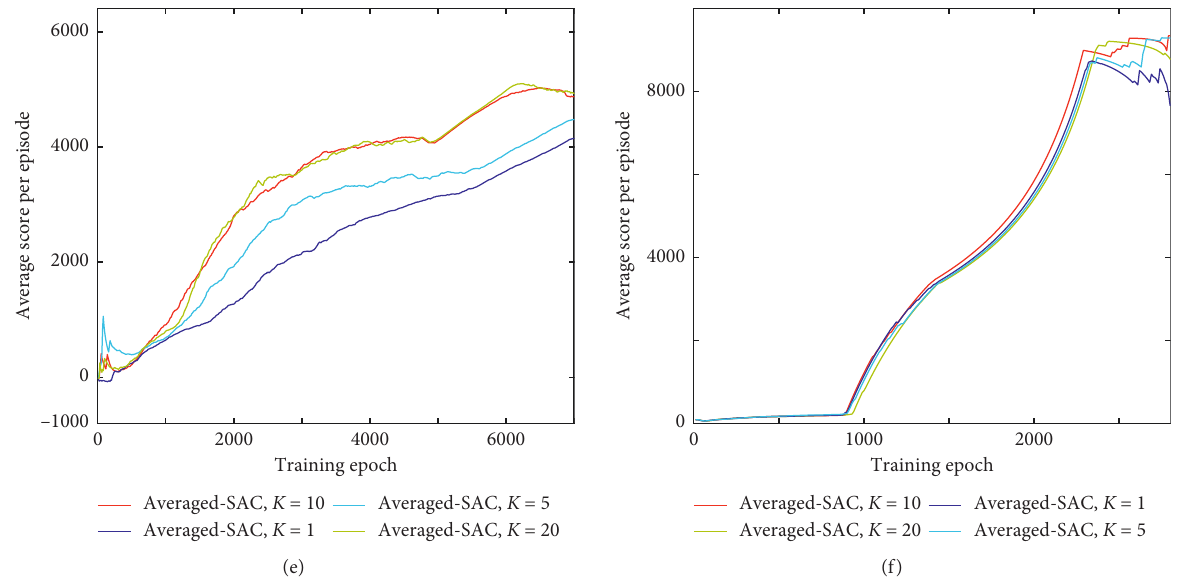
Figure 4: Results of the Averaged-SAC with different K values. (a) Ant-v2. (b) HalfCheetah-v2. (c) Hopper-v2. (d) Humanoid-v2. (e) Walker2D-v2. (f)